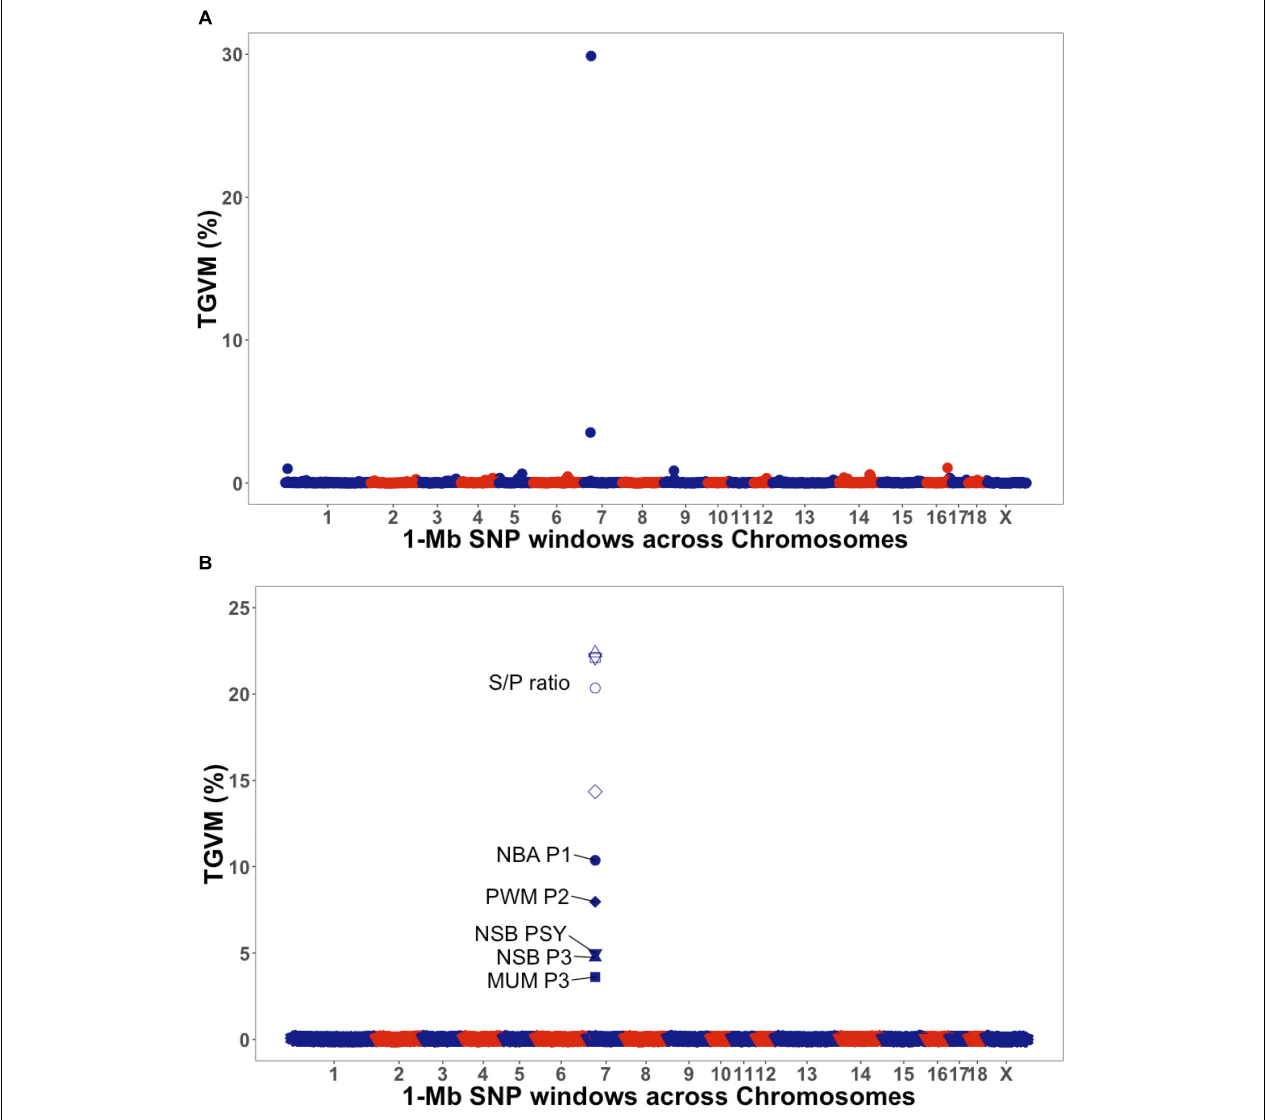
FIGURE 1 | Manhattan plot for univariate and bivariate genome-wide association studies. The y -axis represents the percentage of total genetic variance explained for by markers (TGVM). The x -axis represents the position of 1-Mb single-nucleotide polymorphism (SNP) window across the genome. (A) Manhattan plot for univariate of antibody response [sample-to-positive (S/P) ratio] to porcine reproductive and respiratory syndrome virus vaccination (S/P ratio). (B) Manhattan plot for bivariate of S/P ratio (open symbols) and farrowing performance (solid symbols): number born alive at first parity (NBA P1; circle), pre-weaning mortality at second parity (PWM P2; diamond), number of stillborn at third parity (NSB P3; triangle), pre-weaning mortality at third parity (PWM P3; circle crossed), and number of piglets mummifies at third parity (NSB PSY; inverted triangle).